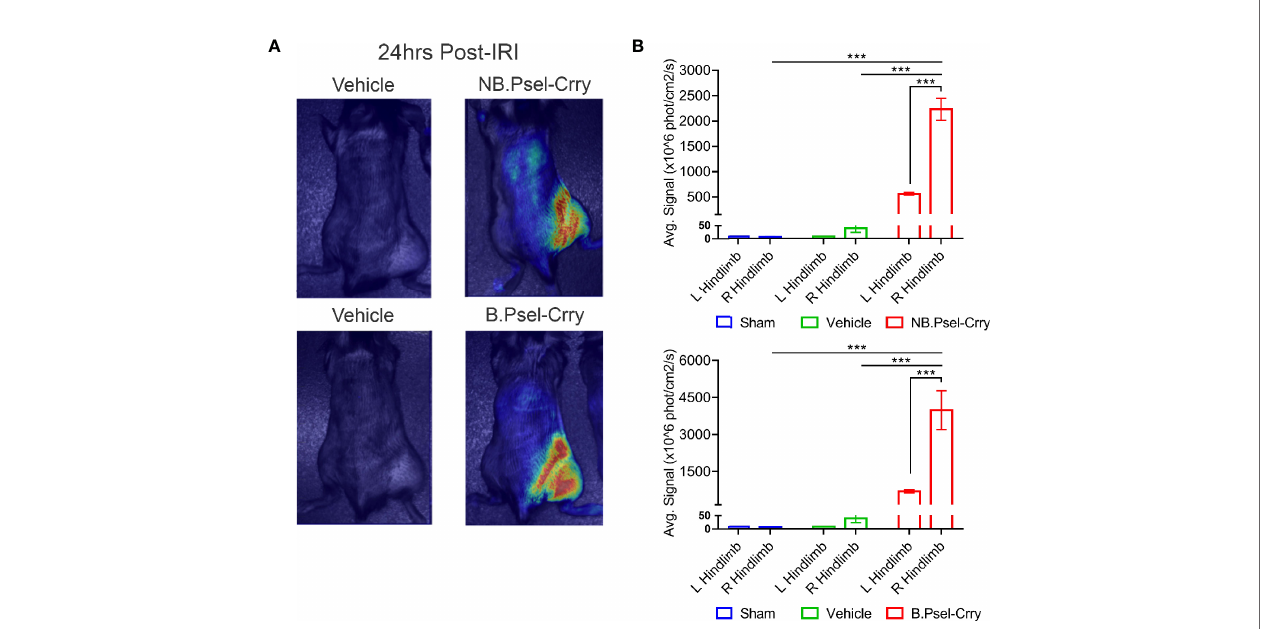
FIGURE 1 | B.PSel-Crry and NB.PSel-Crry speci fi cally traf fi c to hindlimb subjected to ischemia and reperfusion. Fluorescently labeled construct (0.25 mg) was administered i.v. to mice upon reperfusion after 2 hours of ischemia. At 24 h post-administration, mice were imaged with a near infrared Maestro device at 24hrs post-administration. Live animal fl uorescence tomography images were taken at 24 h after construct administration. (A) Representative whole body images. (B) Quanti fi cation of fl uorescence intensity in ipsi and contralateral hindlimbs. Dunnett ’ s correction for multiple comparisons. Quanti fi cation data expressed as Mean ± SD, ***p ≤ 0.001. n = 4.